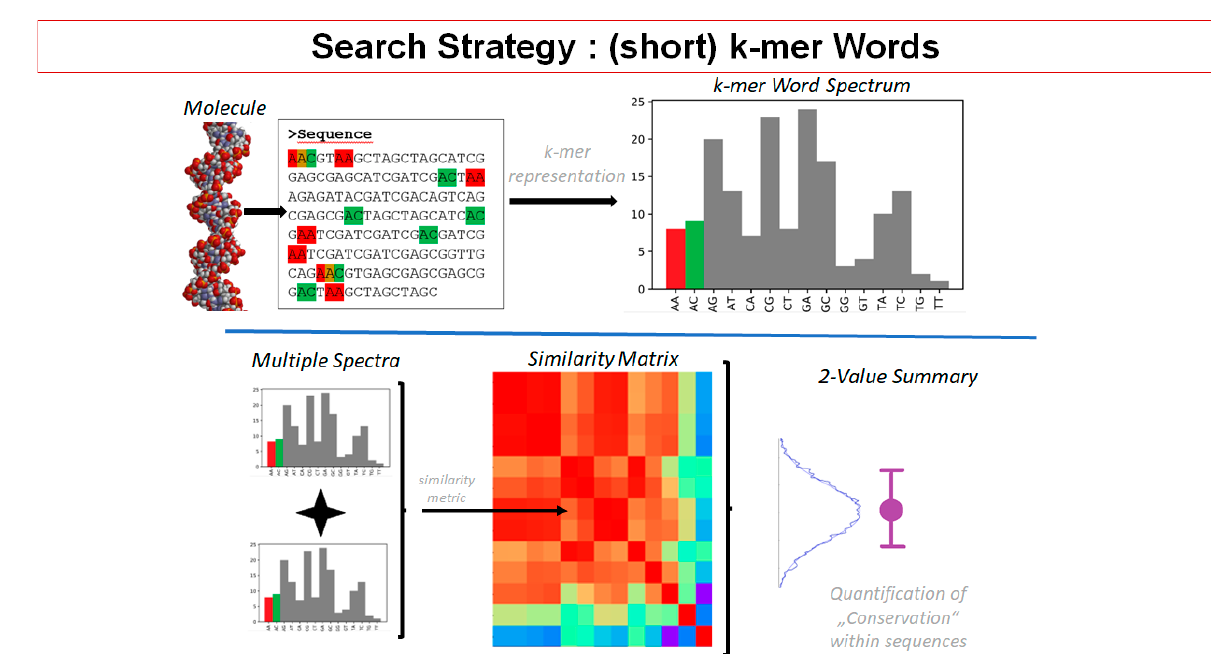
Figure 20. Showing the first steps of the search strategy and analyses for k-mer words. After sequencing, the k-mers are searched for, counted, spectra of abundances of abundances are in pairs correlated and may be given in a heatmap with color-coding for the correlation value. This may be further condensed by averaging all the correlation values and giving the distribution with mean and also deviation.